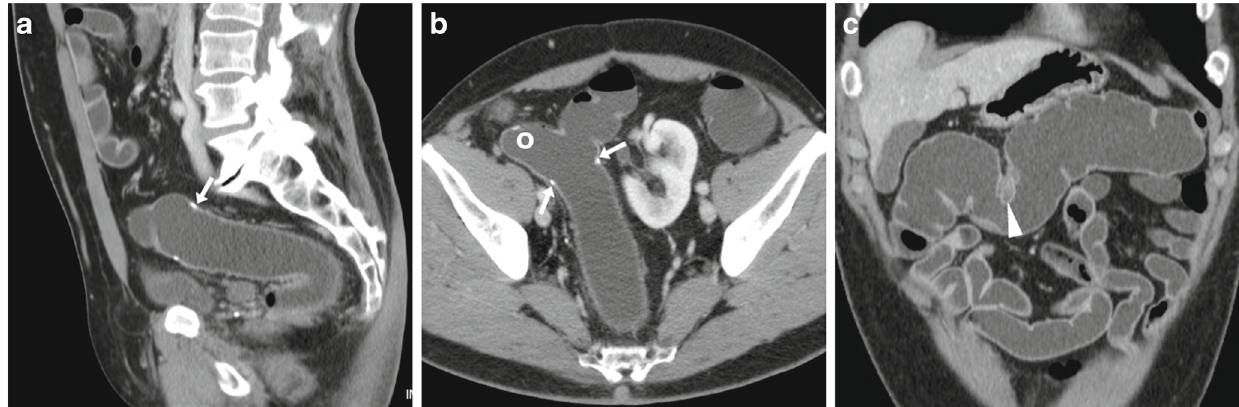
Fig. 13 Metachronous polyp in the residual colon 10 years after left hemicolectomy for carcinoma. WE-MDCT ( a – c ) showed normal colo- colic anastomosis (arrows) with a blind-ending recess (o) and a 1.5 cm